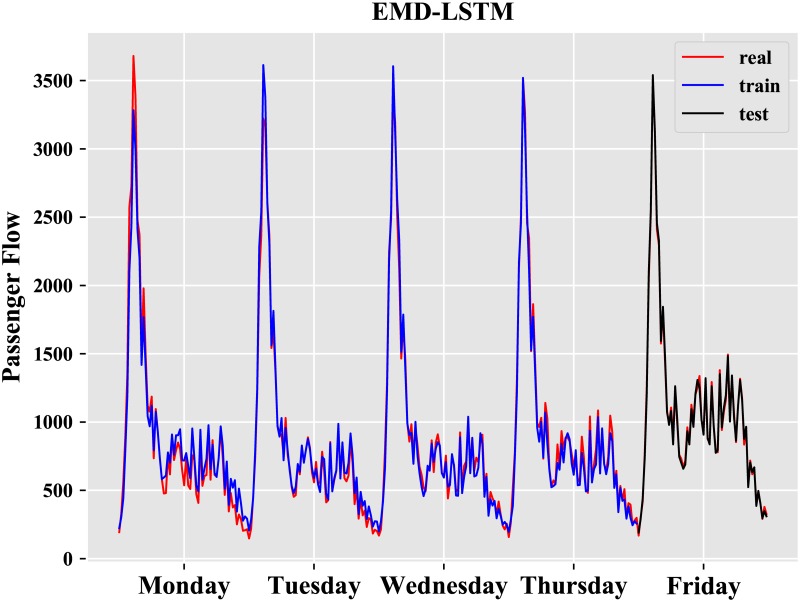
Result of EMD-LSTM.